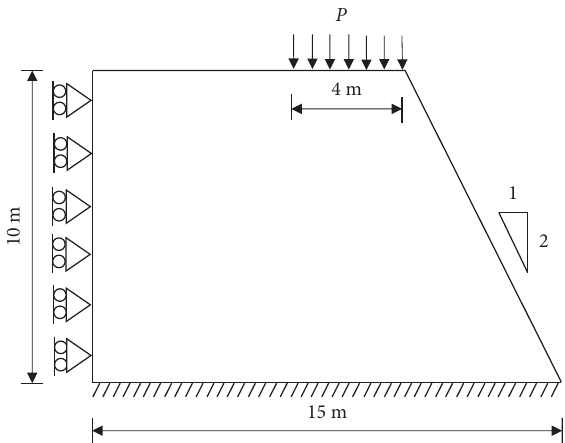
Figure 9: Geometry and boundary conditions for the slope model.